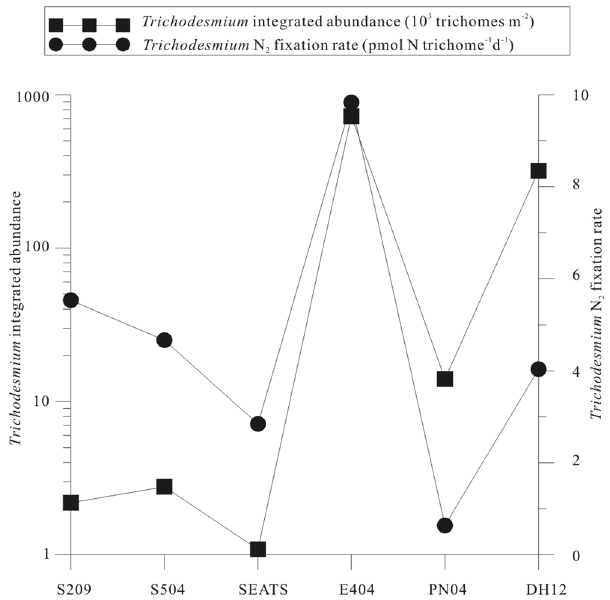
Figure 4. Trichodesmium integrated concentrations and daily N 2 fixation rate in survey region. Note for software: Origin 8.5 PRO